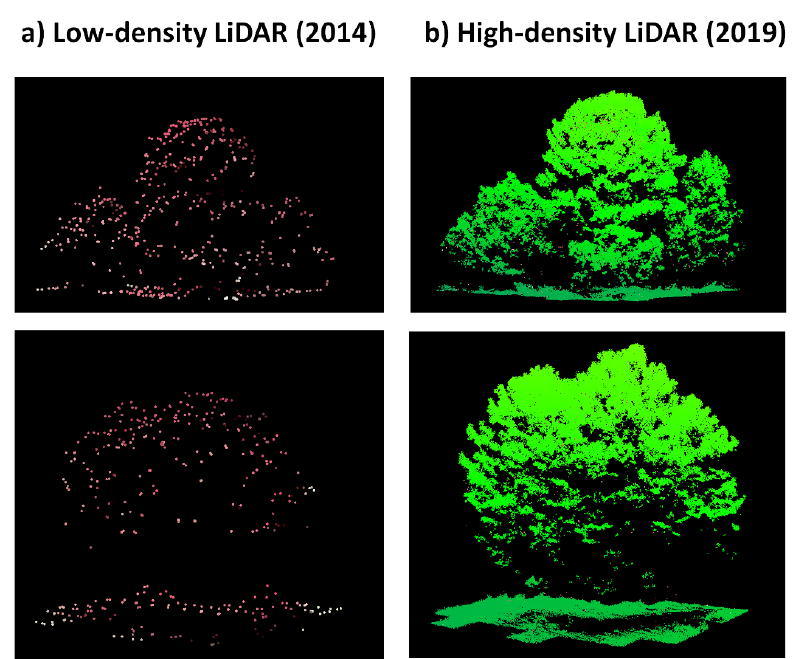
Figure 9. Snapshots of “supra-crowns” derived from ( a ) low-density LiDAR (2014) and ( b ) high- density LiDAR (2019).